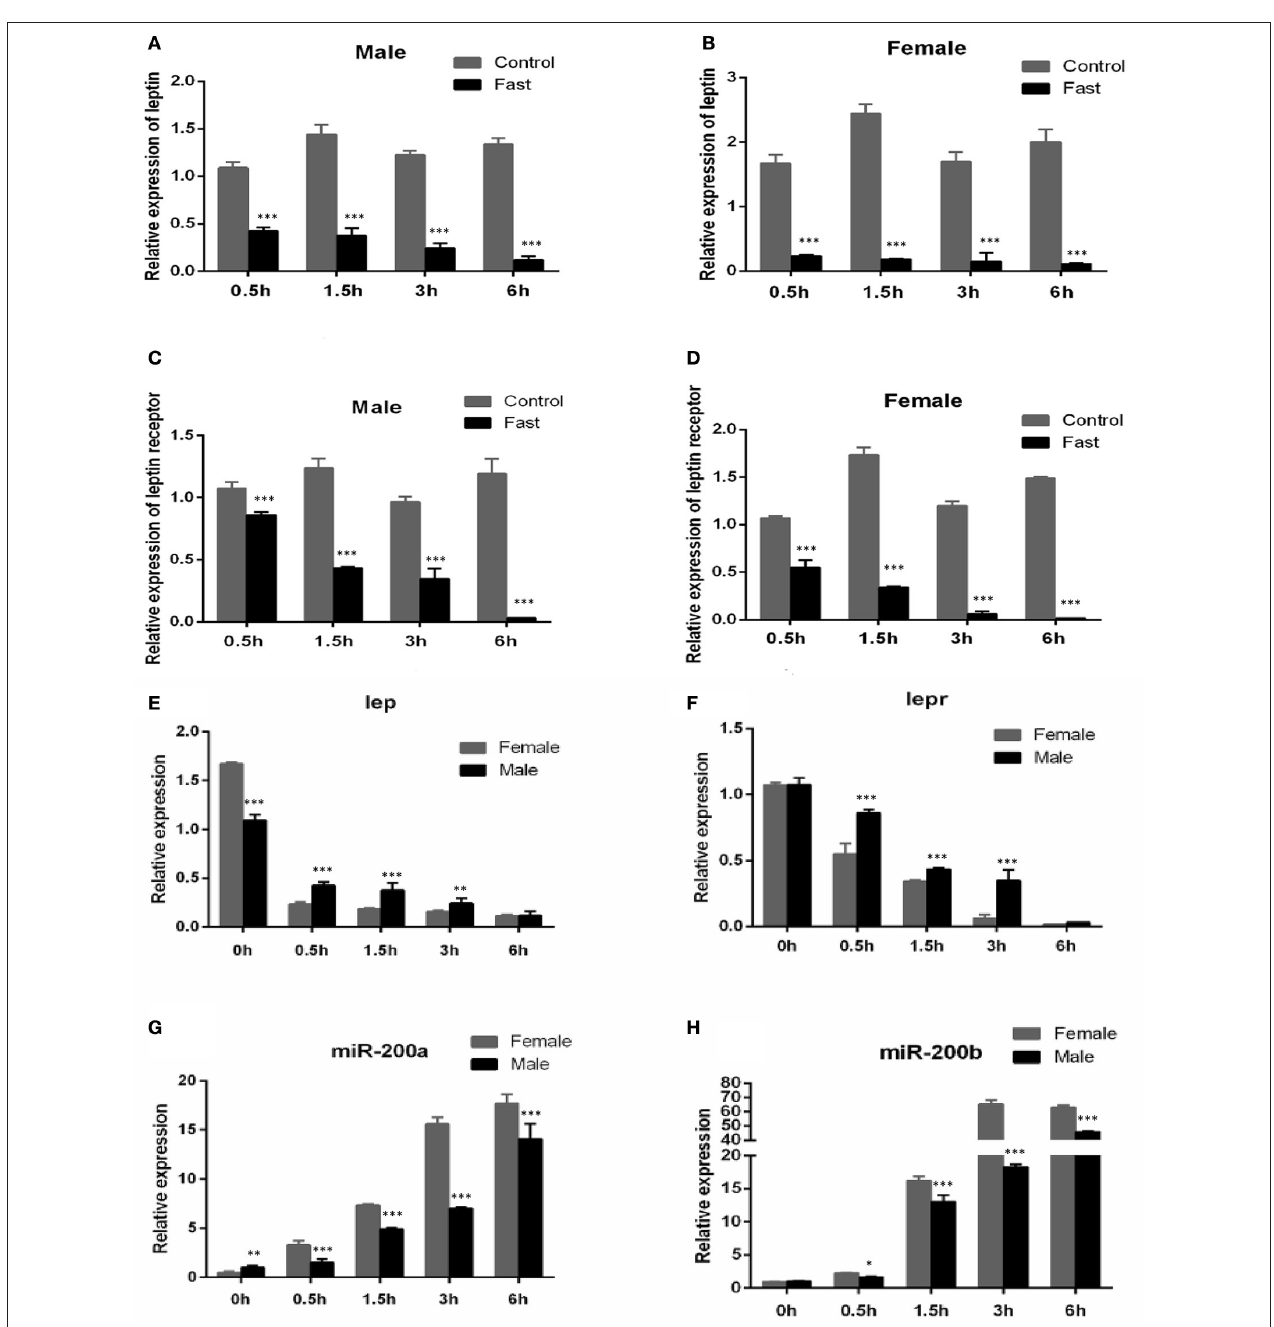
FIGURE 4 | Effects of fasting on the expression of lep , lepr mRNA and miR-200a/b during juvenile growth in yellow catfish. (A–D) showed the effects of short-term fasting on the expression of lep (A,B) and lepr (C,D) mRNA during growth in female and male juvenile yellow catfish respectively. Fast, fasting group; Control, control group. (E–H) showed the effects of short-term fasting on the expression of lep (E) , lepr (F) , and miR-200a (G) and miR-200b (H) mRNA in male and female juvenile yellow catfish, respectively. The asterisk indicates the significant differences of gene expression between different groups (* P < 0.05, ** P < 0.01, and *** P < 0.001).